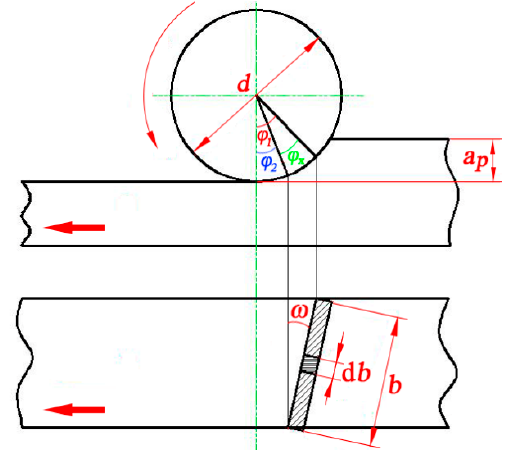
Figure 3. Change of chip width during helical milling process.